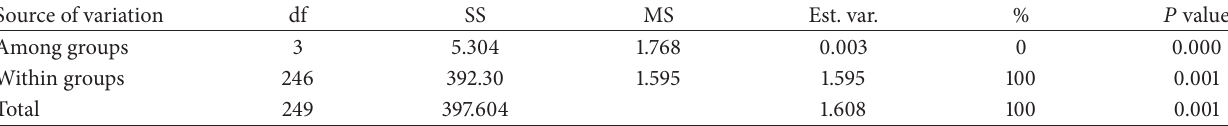
Table 2: Analysis of genetic differentiation among genotypes of 250FS progenies by AMOVA. Source of variation